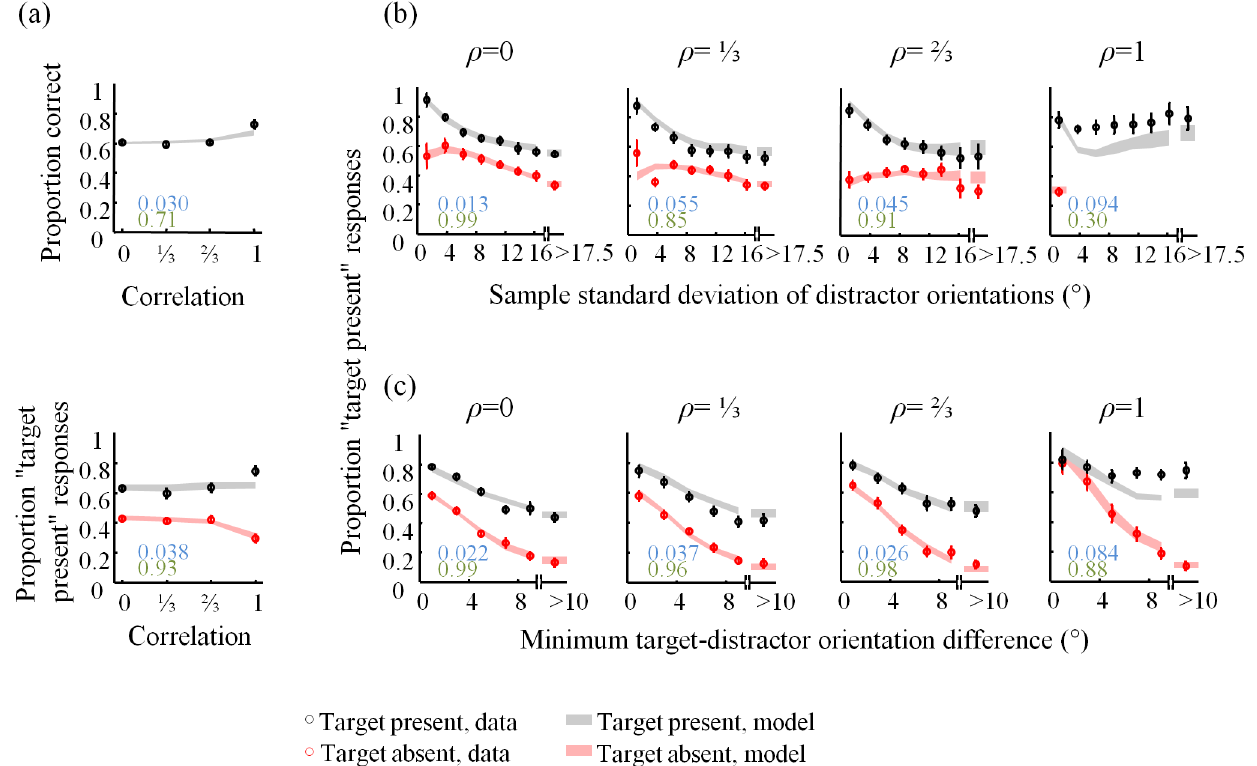
Fig 7. Fits of the VP4 model to the summary statistics. (a) Proportion correct (top), hit, and false-alarm rates (bottom) as a function of distractor correlation. Proportion “ target present ” responses as a function of (b) standard deviation of the distractor set, and (c) minimum target-distractor orientation difference, averaged across subjects, separately for target present (black) and target absent (red) trials. Numbers indicate root-mean square error (blue) and R 2 statistics (green) between model and